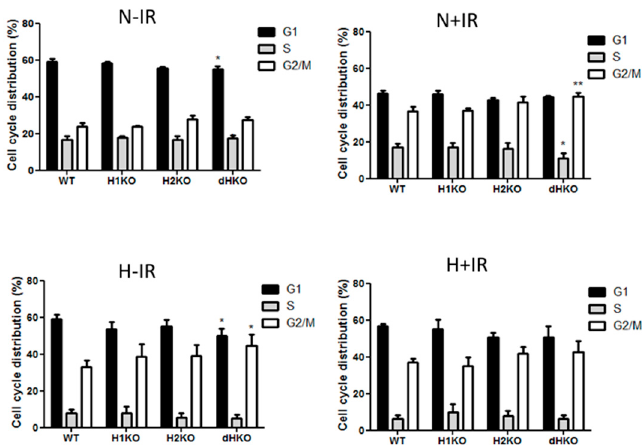
Figure 5. Flow cytometry analysis of cell cycle distribution of H1299 cells after 2Gy radiation under normoxic (21%) and hypoxic (0.2%) conditions. Fraction of cells in G1, S and G2-M phase in non-irradiated cells under normoxia and hypoxia and 4 h post-irradiation in normoxic and hypoxic cells. Average ± SD of three independent biological repeats is shown. Asterisks indicate statistical significance (* p < 0.05; ** p < 0.01).